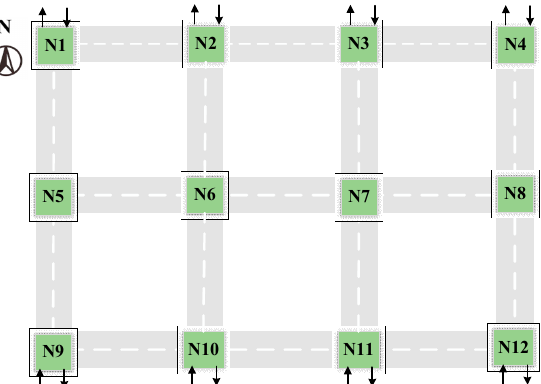
Figure 5. A schematic diagram of the simulated multi-intersection road networks.